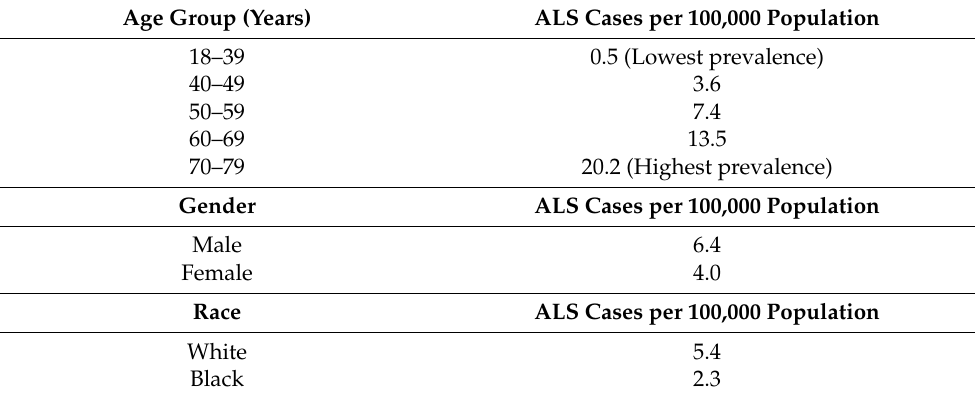
Table 1. Estimated prevalence of Amyotrophic Lateral Sclerosis (ALS) in United States by age, sex, and race by the National ALS Registry, United States